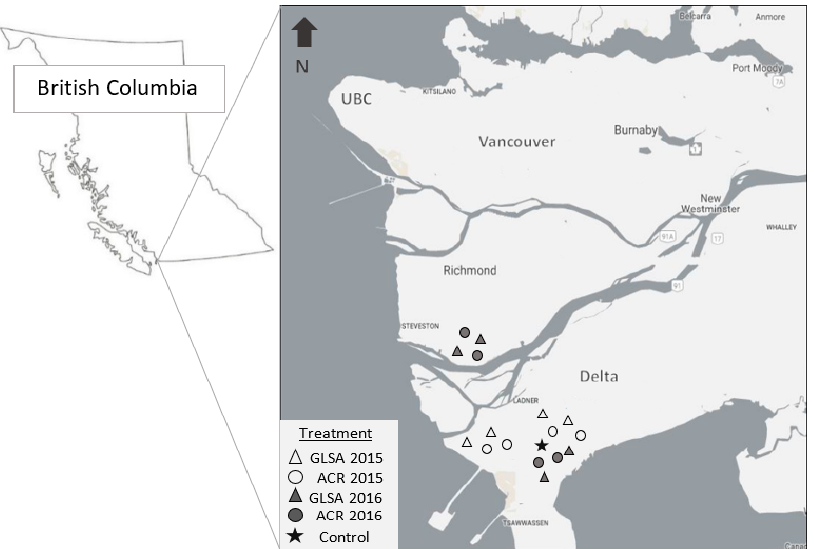
Figure A1. Map of the Lower Fraser River delta with the location of regional analysis fields in annual crop rotations (ACR-circles) and following 3-year grassland set-asides (GLSA-triangles) in 2015 and 2016 as well as the controlled experiment (star) in Delta, British Columbia, Canada.